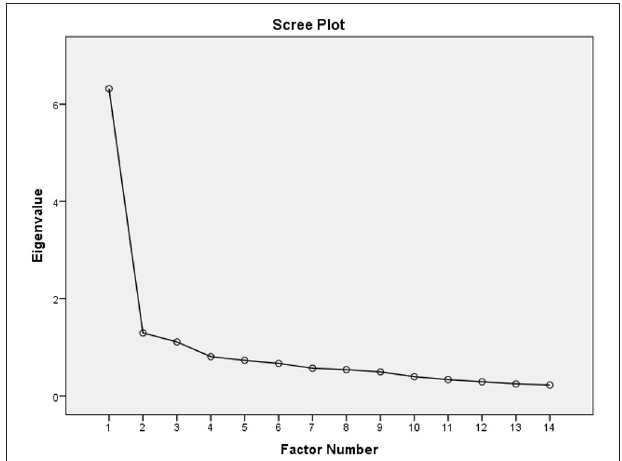
FIGURE 1 | Scree plot illustrating the factor loadings with parallel analysis of the Lithuanian version of the Compulsive Internet Use Scale (CIUS).